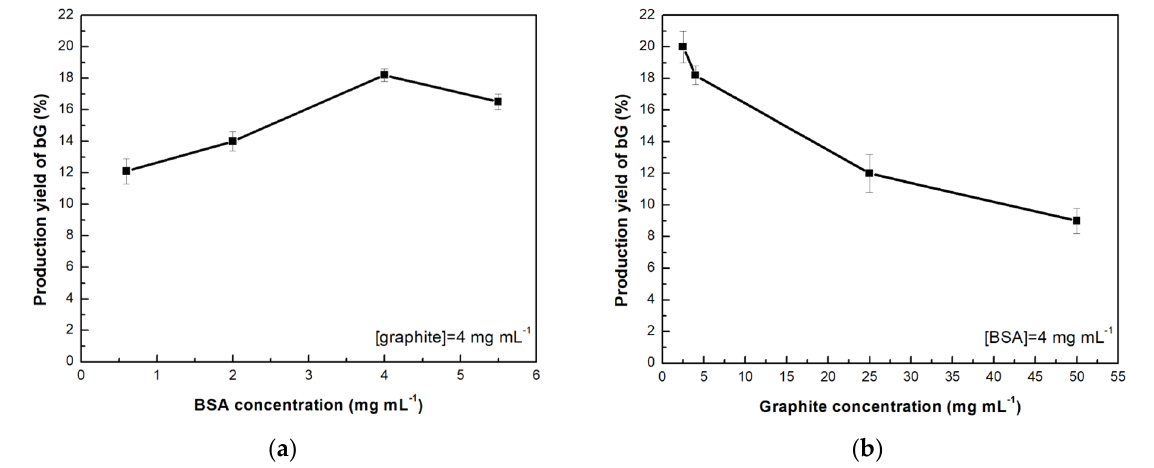
Figure 2. Production yield (%) of bio-Graphene as a function of ( a ) bovine serum albumin, and ( b ) graphite concentration.